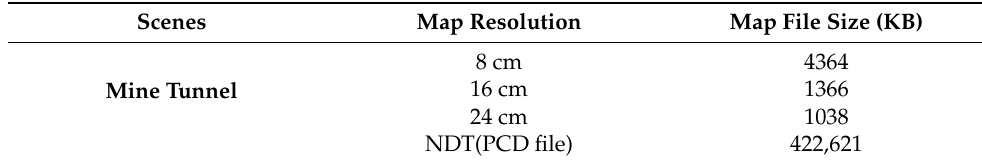
Table 8. File sizes for different resolution the EQT map of mine tunnel, PCD file size. Scenes Map Resolution Map File Size (KB) Mine